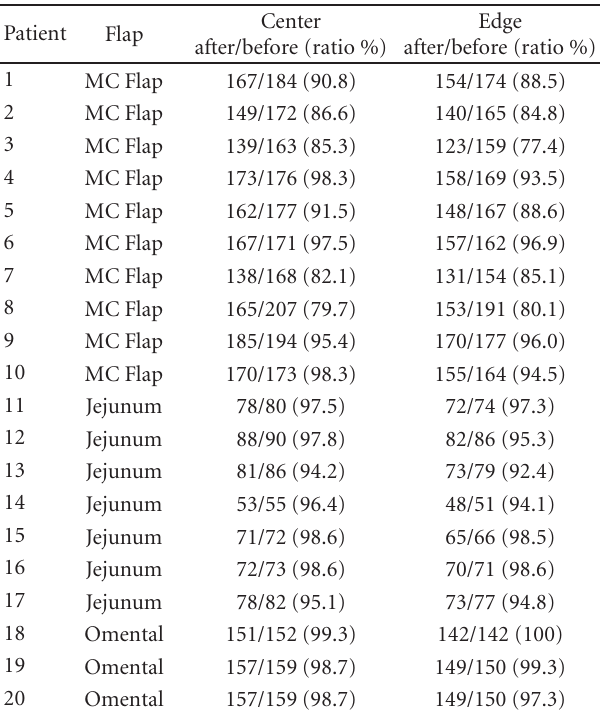
Table 2: Average derivative of edge and the flap center at the previous state of main nourishment vascular separation before and sewing the flap